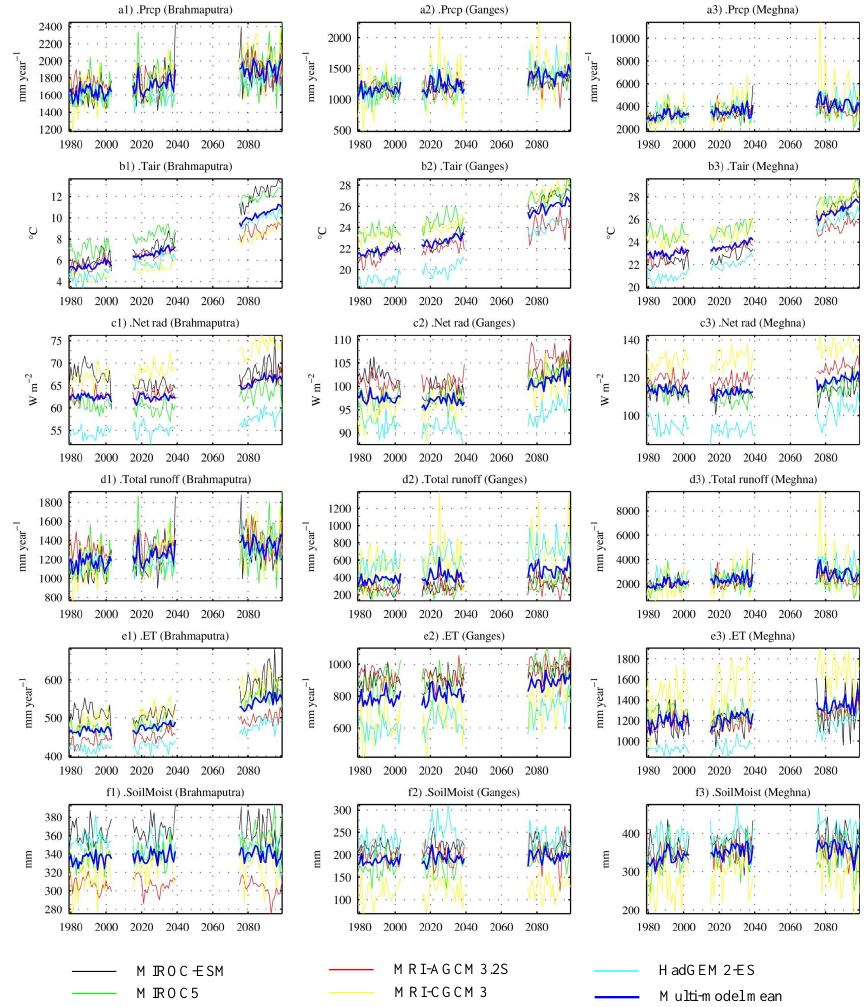
Figure 7. (a1) – (f3) Interannual variation of mean of meteorological and hydrological variables of five GCMs for the present-day